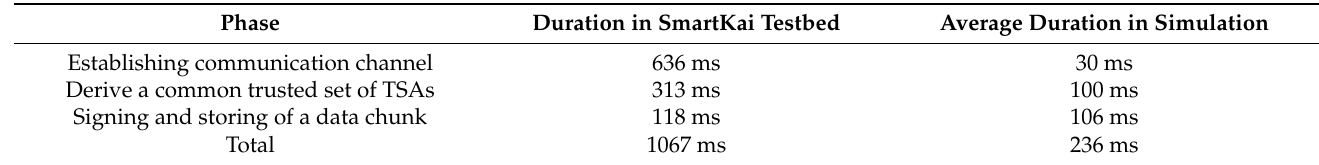
Table 2. Time required by the approach in the evaluation scenario depending on the respective phase.